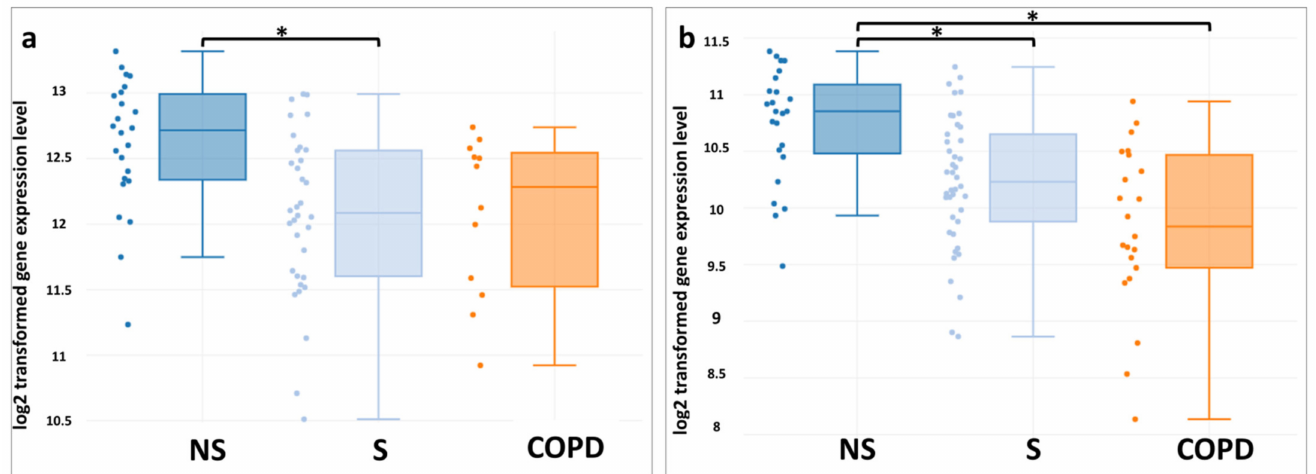
Figure 2. Patterns of expression of the ABCA1 gene in alveolar macrophages ( a —GSE13896; b —GSE130928) associated with smoking status: between healthy non-smokers (NS, dark blue color) and smokers without a COPD diagnosis (S, light blue color) and with a COPD diagnosis (COPD, orange color). All datasets were generated from the Affymetrix Human Genome U133 Plus 2 microarray platform. GSE13896 used the Mas 5.0 Normalization method and GSE130928 used the RMA Normalization method. The data distribution is visualized in the form of box diagrams. Statistically significant differences ( p values and p values adjusted using the algorithm of Benjamini & Hochberg) are shown with asterisks: * p < 0.01, FDR ≤